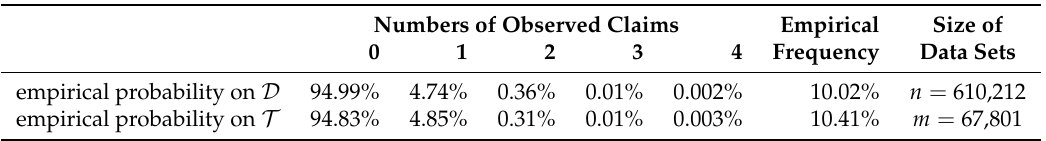
Table 1. Learning and test data D and T , respectively: the last columns provide the empirical frequency on these two data sets and the underlying number of policies, the other columns show the split of the policies according to the numbers of observed claims; this partition is identical to Noll et al. (2018); Wüthrich (2019). Numbers of Observed Claims Empirical Size of 0 1 2 3 4 Frequency Data Sets empirical probability on D 94.99% 4.74% 0.36% 0.01% 0.002% 10.02% n = 610,212 empirical probability on T 94.83% 4.85% 0.31% 0.01% 0.003% 10.41% m =